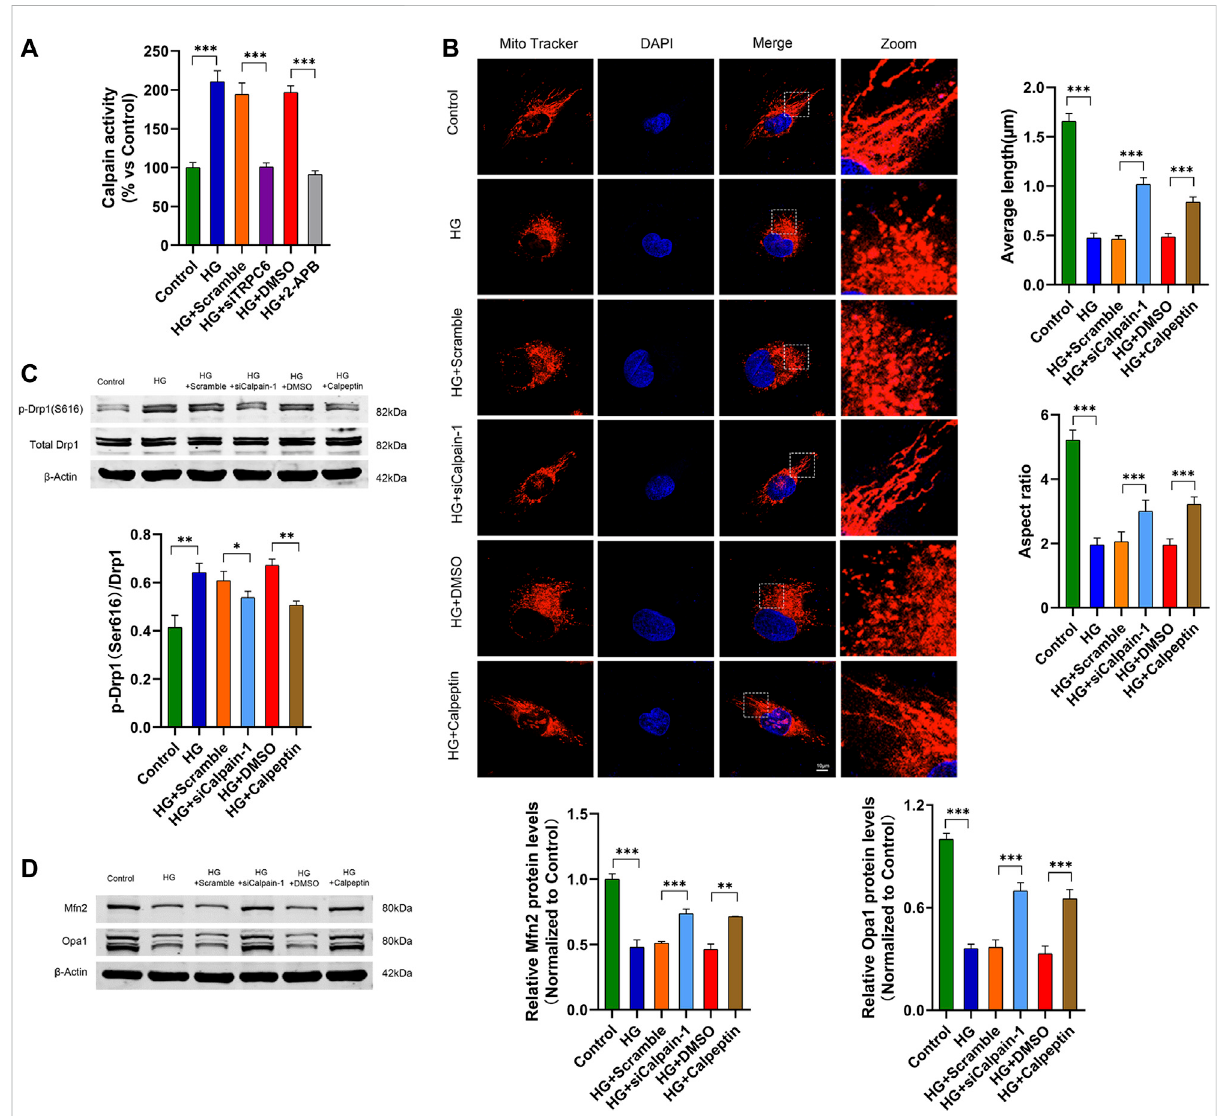
FIGURE 5 TRPC6mediatesHG-induced mitochondrial fi ssionthroughcalpain-1activation inpodocytes. (A) Calpainactivityassaydatainthecontrol,HG, HG + scramble, HG + siTRPC6, HG + DMSO, and HG + 2-APB groups ( n = 5 independent experiments). (B) MitoTracker Red and DAPI staining, and analysisofaveragelengthandaspectratiobyImageJsoftwareinthecontrol,HG,HG+scramble,HG+siCalpain-1,HG+DMSO,andHG+calpeptin groups. Scale bars, 10 μ m ( n = 5 independent experiments). (C) Representative Western blot and quantitation analysis of p-Drp1 (Ser616) and total Drp1 in the six groups ( n = 3 independent experiments). (D) Representative Western blot and quantitation analysis of Mfn2 and Opa1 in the six groups ( n = 3 independent experiments). * p < 0.05; ** p < 0.01; *** p <